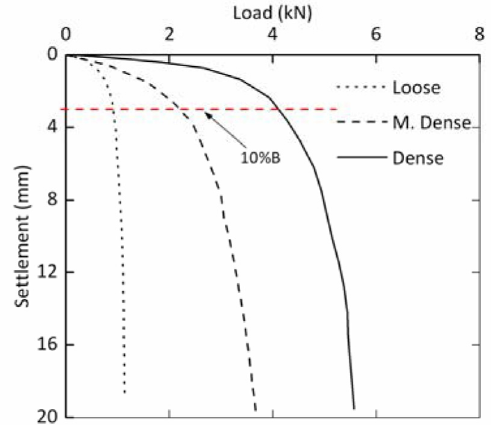
Fig. 5. Load versus settlement response of single driven piles from load tests for different sand relative